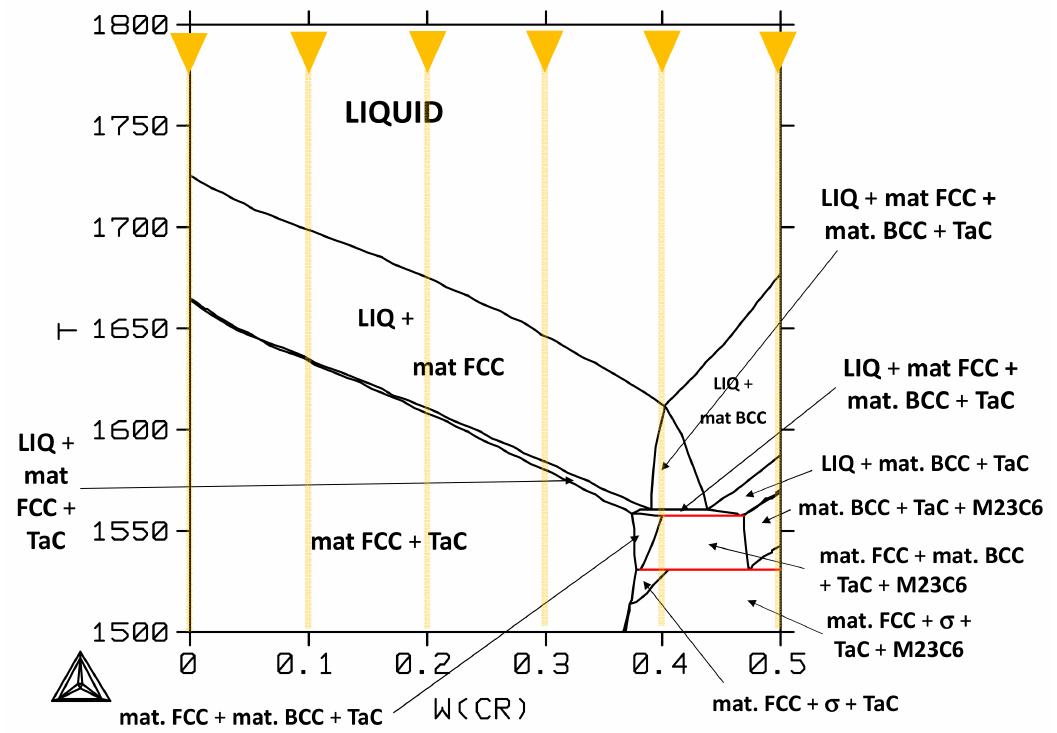
Figure 10. High-temperature part of a (0.4wt%C, 6wt.%Ta) isopleth, computed with Thermo-Calc (the six alloys are materialized by orange triangles followed by vertical